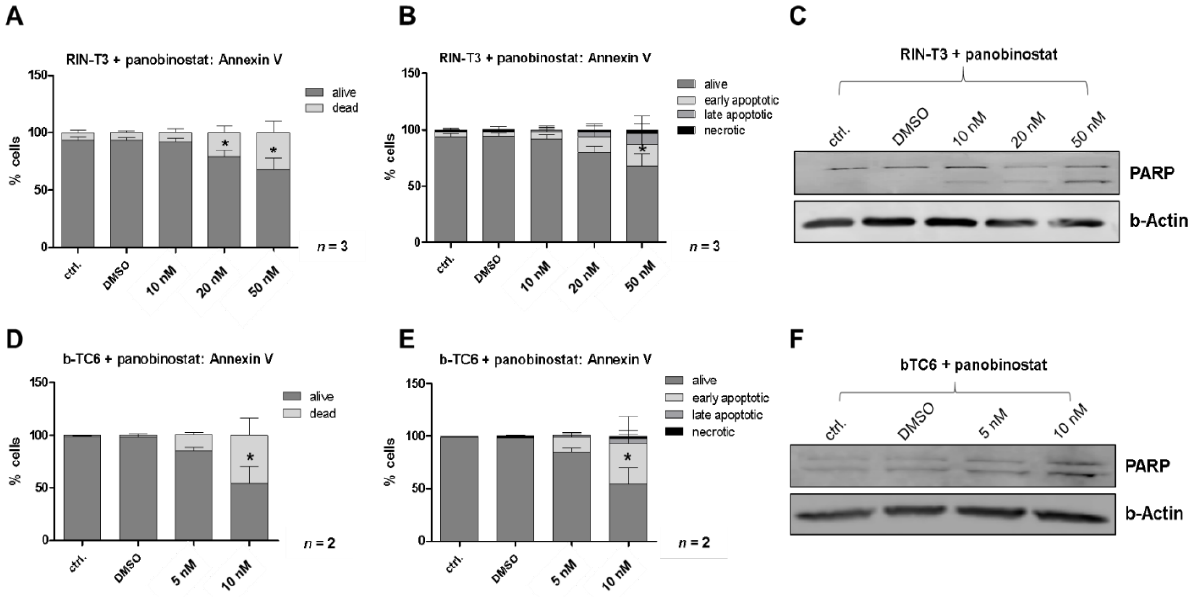
Figure 2. Panobinostat induces an apoptotic phenotype in murine NET cells. RIN-T3 (rat) and b-TC6 (mouse) cells were treated with panobinostat (PB) (5 nM, 10 nM, 20 nM, 50 nM) and analyzed for apoptosis. ( A , B ), ( D , E ): Flow cytometric analyses determined an increase of dead cells after PB treatment for RIN-T3 and b TC6, which are mostly early apoptotic ( B , E ). ( C , F ): Western blot analyses show modified protein levels of the apoptotic marker (PARP cleavage) after 24 h of PB treatment in both RIN-T3 and b-TC6 cells, compared to the control (ctrl., DMSO). Error bars: SD; n = 3 for RIN-T3, n = 2 for b-TC6; * p < 0.05, according to an unpaired one-sample Student’s t -test.